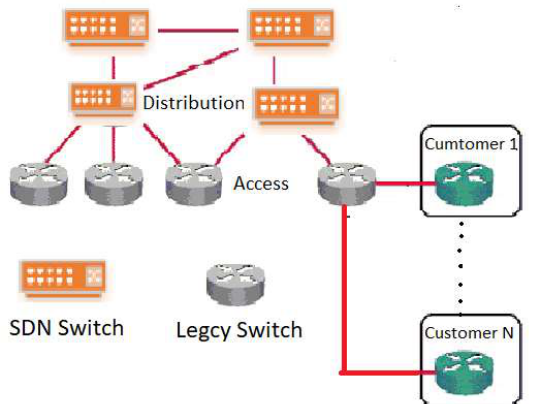
Figure 1. An Example of hybrid SDN scenario: OpenFlow switches are deployed in the distribution network to obtain the benefits of SDN while millions of forwarding entries are handled in the access network by using legacy devices.